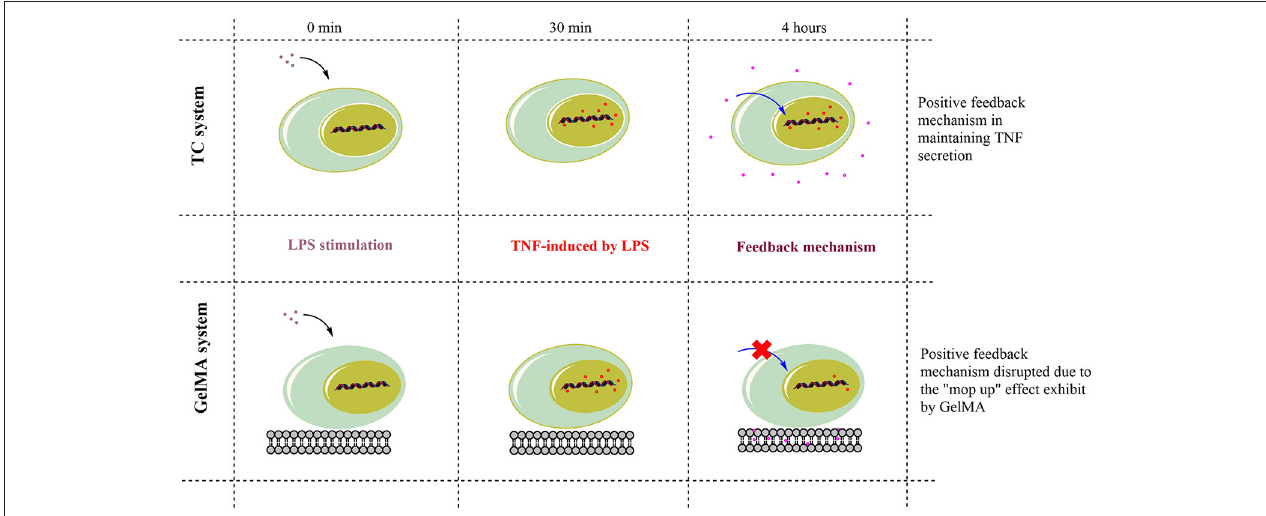
FIGURE 5 | Schematic action mechanism for GelMA in the modulation of TNF- α . TNF- α gene expression increased within 30min of LPS stimulation in both TC and GelMA conditions. After 4h, LPS-induced TNF- α expression is maintained through a positive feedback mechanism and levels of secreted TNF- α peak in TC. Whereas the GelMA hydrogel sequesters secreted TNF- α protein, thereby effectively removing it from solution. This disrupts the relay of positive feedback signals to the cell for the maintenance of TNF- α expression. Thus, by 4h, in cells cultured on GelMA TNF- α mRNA levels are suppressed to the levels of un-stimulated cells and there is also no detectable increase in soluble TNF- α in the